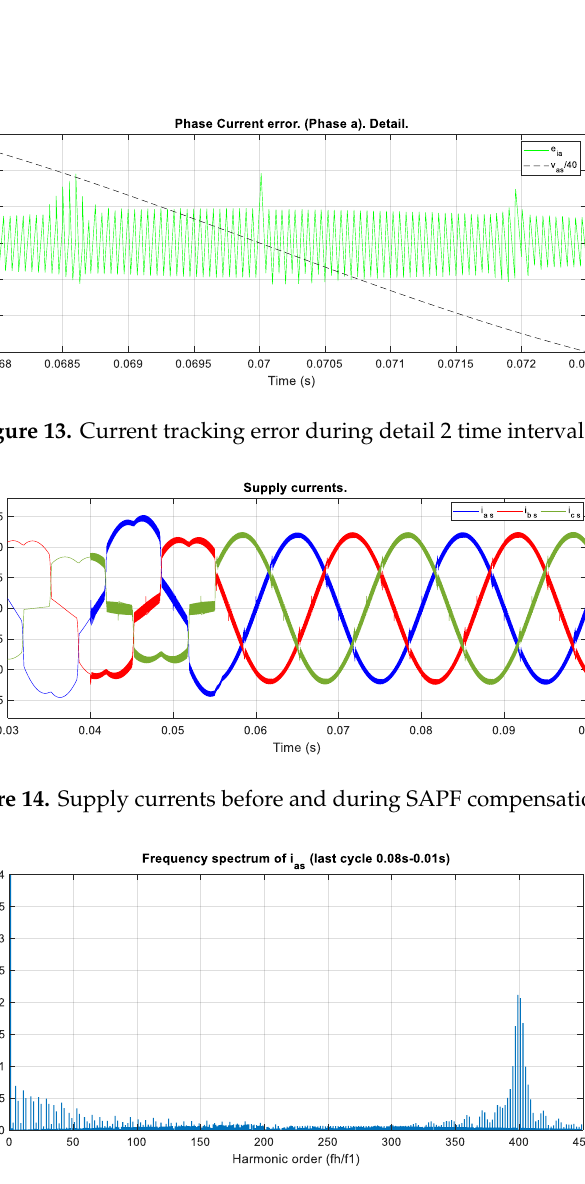
Figure 15. Supply current harmonic components during SAPF compensation.